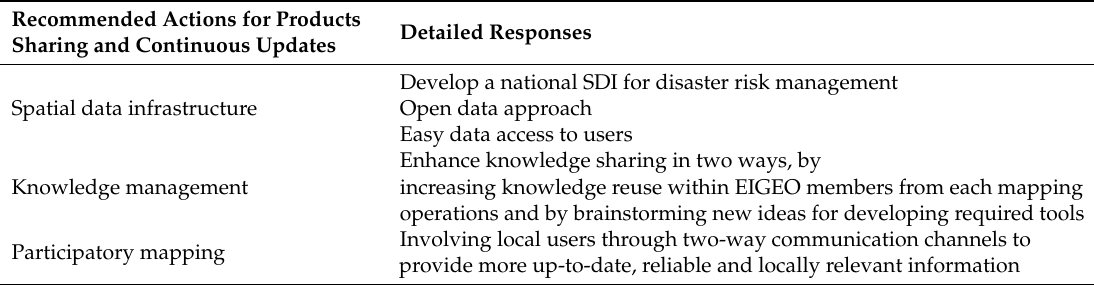
Table 9. Recommendations for EIGEO products sharing and continuous updates (e)